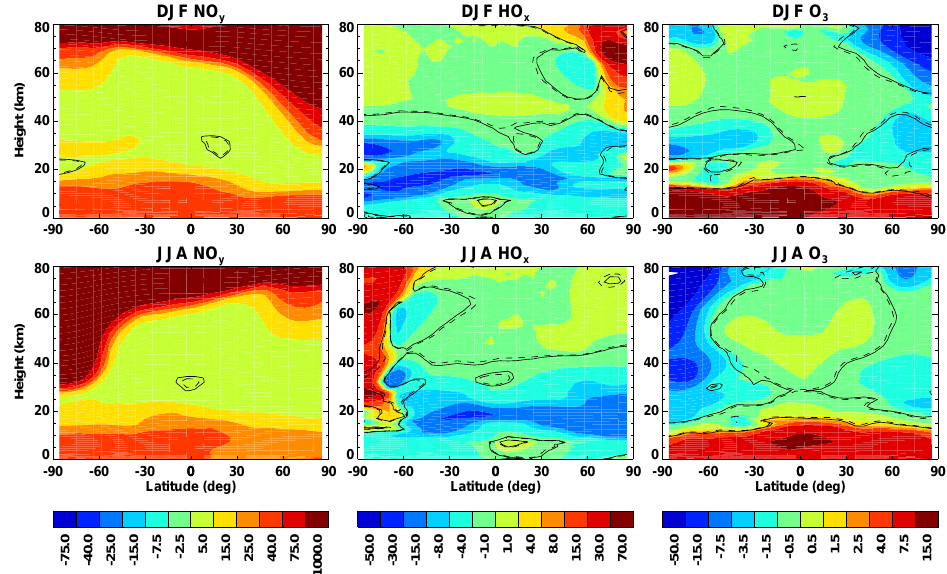
Fig. 17. Run mean, ensemble mean differences between the two ensembles shown in Fig. 14 for NO y (left, %), HO x (center, %) and O 3 (right, %).